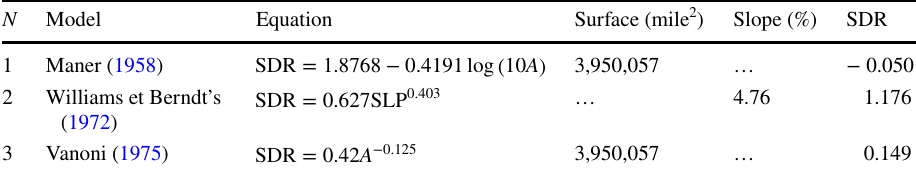
Table 4 SDR results of the models used